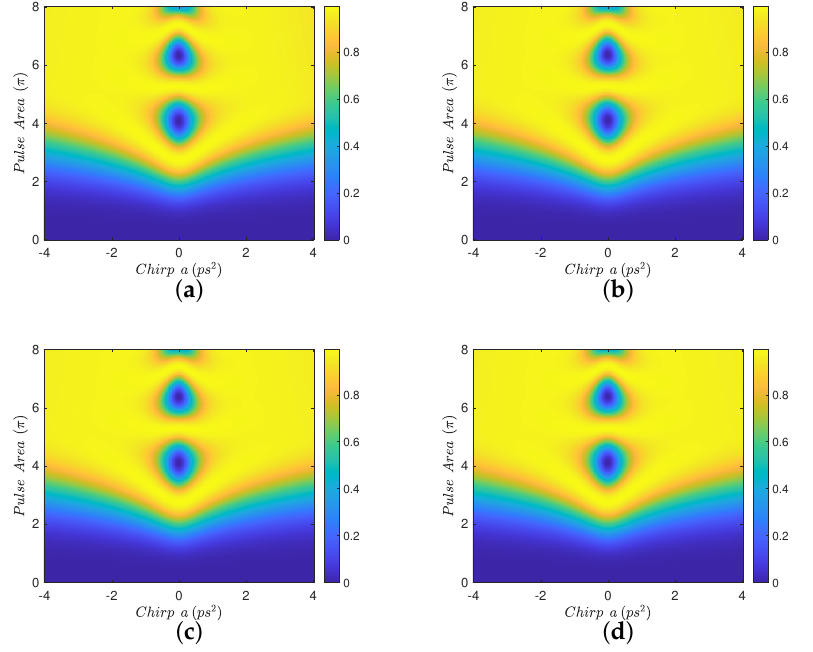
Figure 9. Contour diagrams for the biexciton population at the final time, as function of the pulse area and the chirp parameter a of the applied Gaussian pulse, with biexciton energy shift E b = − 15 meV, initial Gaussian pulse duration τ 0 = 0.75 ps, interparticle distance R = 1.5 r mnp , and four different nanoparticle radii: ( a ) r mnp = 9 nm, ( b ) r mnp = 10 nm, ( c ) r mnp = 12 nm, and ( d ) r mnp = 15